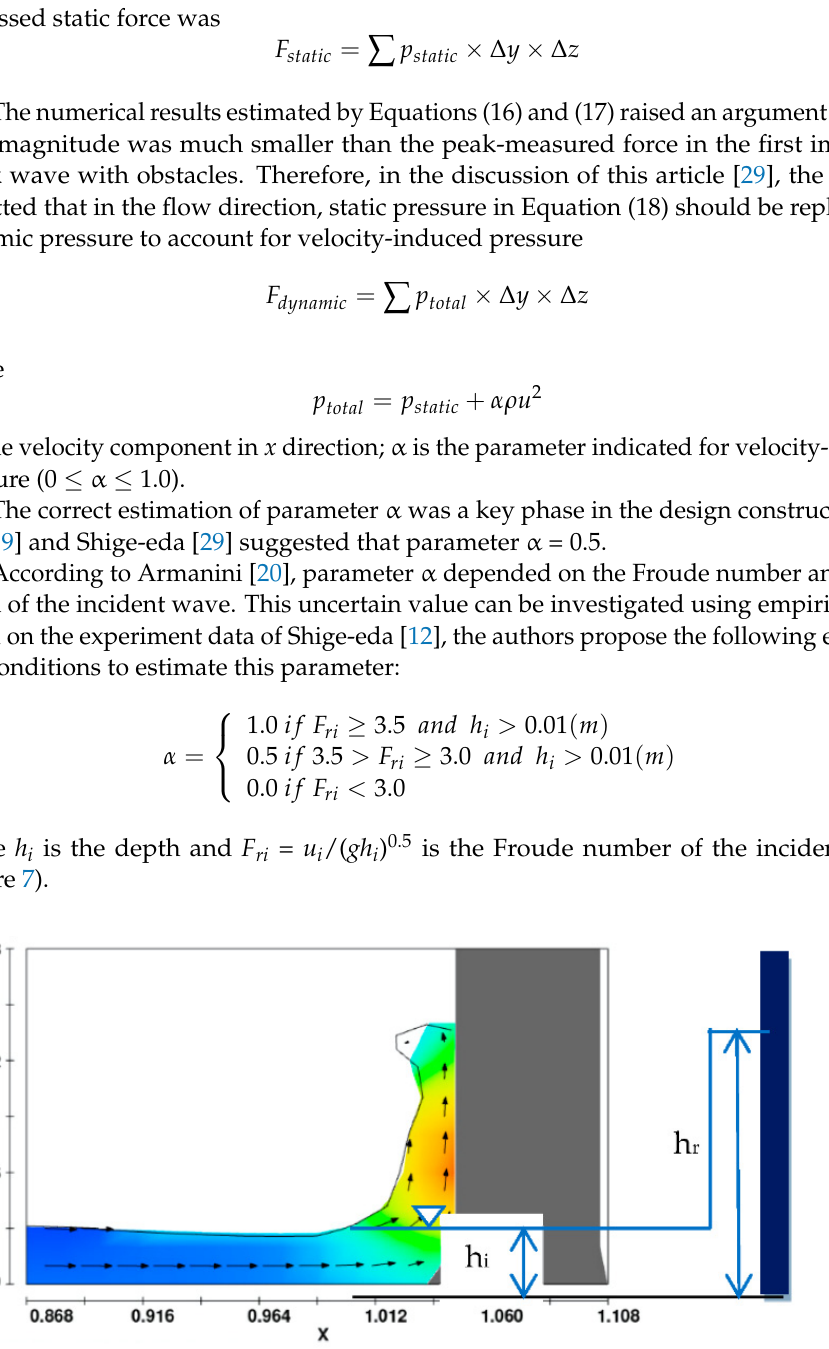
Figure 7. Formation of incident and reflected